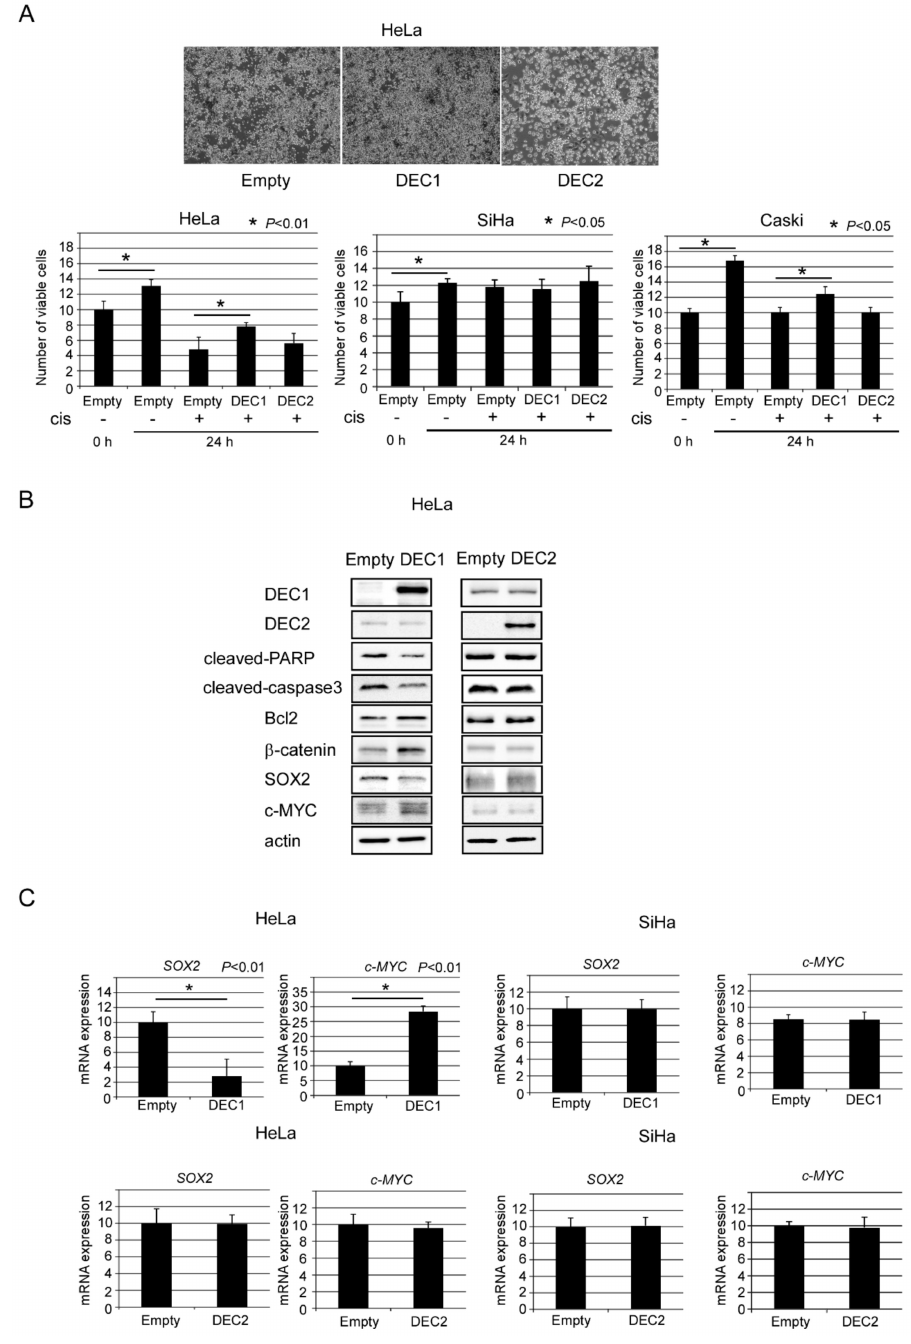
Figure 3. DEC1 has anti-apoptotic e ff ects in HeLa cells under apoptosis. ( A ) Cell viability of HeLa, SiHa and Caski cells with ( + ) or without ( − ) cisplatin and empty vector, DEC1 or DEC2 plasmid treatment was determined. The absorbance (OD 480 / OD 650 ) at 0 and 24 h is shown. The value of cell viability of control 0 h regarded as 10. Data are expressed as mean values ± SE (bars) of three independent samples. * p < 0.05, as determined using t -test. ( B ) Western blotting images of DEC1, DEC2, cleaved-PARP, cleaved-caspase 3, Bcl-2, β -catenin, SOX2, c-MYC and actin treated with 50 µ M cisplatin and empty vector, DEC1 or DEC2 plasmid in HeLa cells. Western blot analysis was repeated three times and similar results were obtained. ( C ) SOX2 and c-MYC mRNA expressions in HeLa and SiHa cells with cisplatin and empty vector, DEC1 or DEC2 plasmid treatment. Data are expressed as mean values ± SE (bars) of three independent samples. * p < 0.01, as determined using t-test. qPCR was repeated three times and similar results were